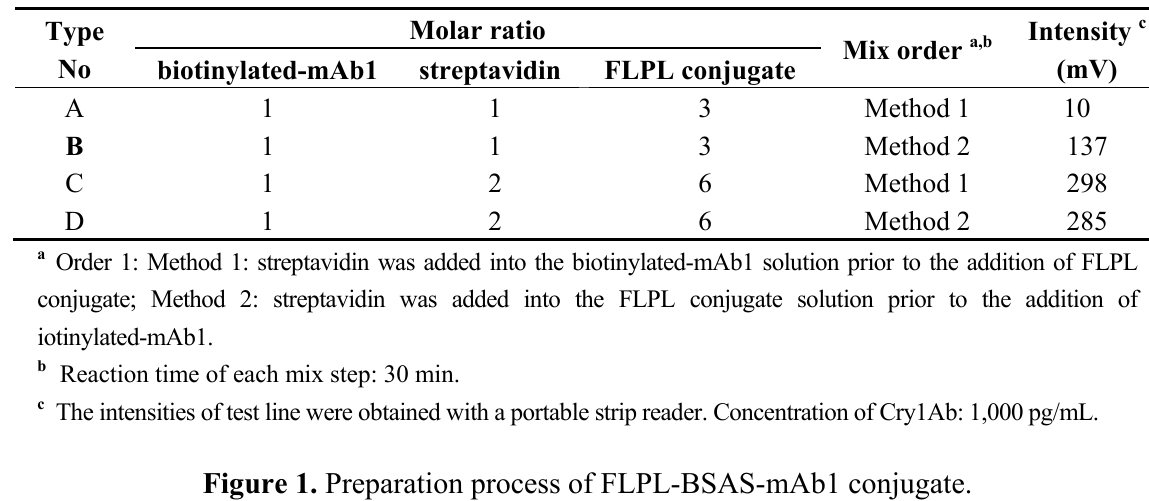
Figure 1. Preparation process of FLPL-BSAS-mAb1